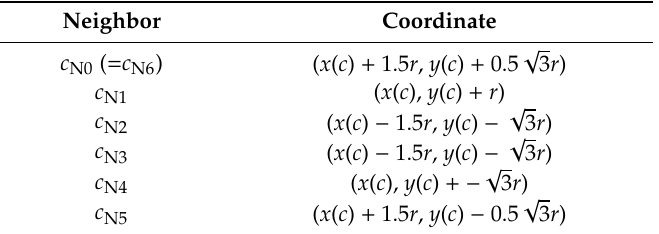
Table 2. The neighbors of cell c . For a cell c with radius r , the coordinates of each neighbor are as follows.